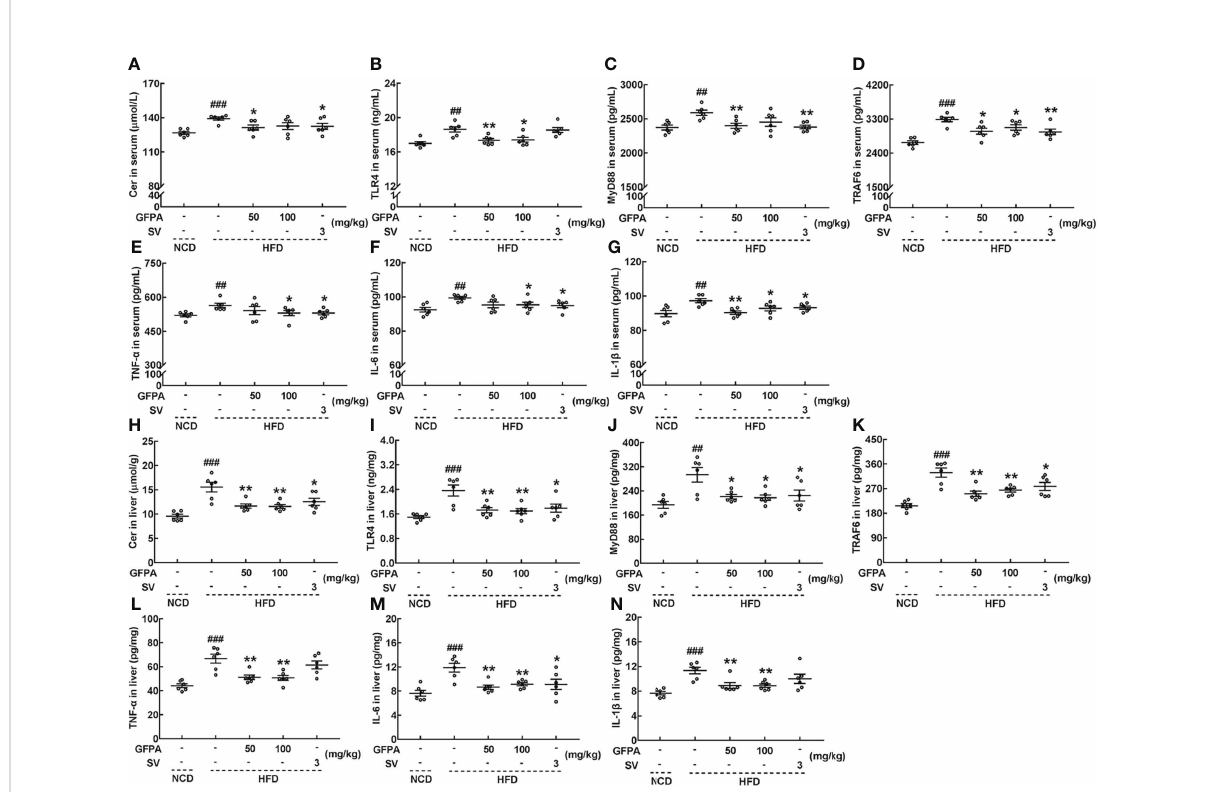
FIGURE 5 GFPA suppressed the obesity-induced in fl ammatory response in mice with DIO. GFPA decreased the serum concentrations of (A) Cer, (B) TLR4, (C) MyD88, (D) TRAF6, (E) TNF- a , (F) IL-6 and (G) IL-1 b and the hepatic concentrations of (H) Cer, (I) TLR4, (J) MyD88, (K) TRAF6, (L) TNF- a , (M) IL-6 and (N) IL-1 b in HFD-fed mice. Data are expressed as means ± S.E.M. (n = 6). ## p < 0.01 and ### p < 0.001 versus NCD-fed mice; * p < 0.05 and ** p < 0.01 versus HFD-fed mice.